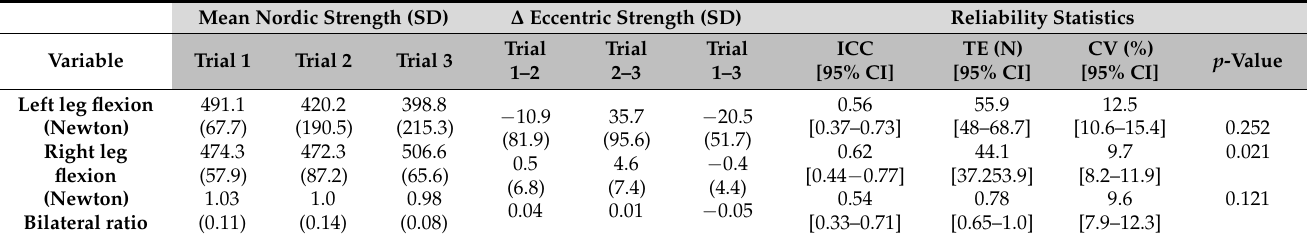
Table 3. Descriptive and reliability statistics related to intersession of Nordic eccentric hamstring strength values (maximal value from three trials). Values include mean, standard deviation, and 95% confidence intervals (upper, lower) for left leg, right leg, and balance. p -value from repeated measures analysis of variance. CI: confidence interval, CV: coefficient of variation, ICC: intraclass correlation coefficient, SD: standard deviation, T1: trial 1, T2: trial 2, T3, trial 3, TE: typical